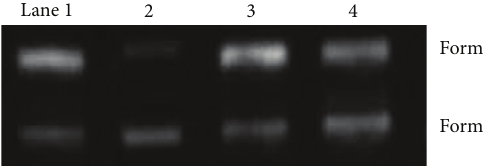
Figure 8: Cleavage of super coiled pUC19 (10 𝜇 M) by the Cu(II), Co(II), and Ni(II) complexes in the presence of triacetate EDTA (TEA) buffer at 37 ∘ C. Upper line: Form I and lower line: Form II; Lane 1: DNA-control; Lane 2: L–Cu; Lane 3: L–Co; Lane 4: L–Ni.